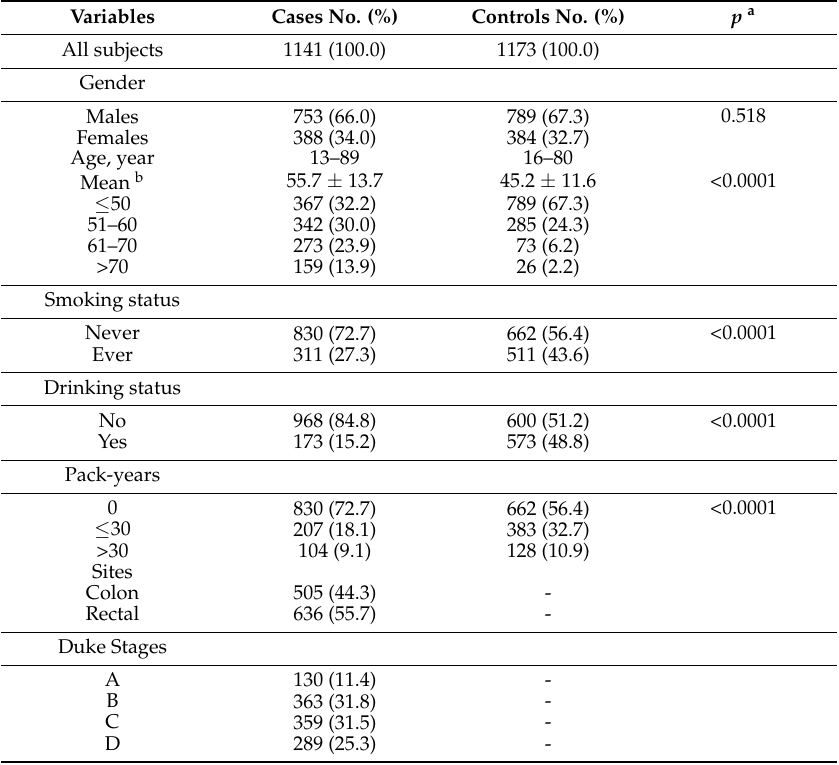
Table 1. Clinical and demographic characteristics of colorectal cancer patients and cancer-free controls.